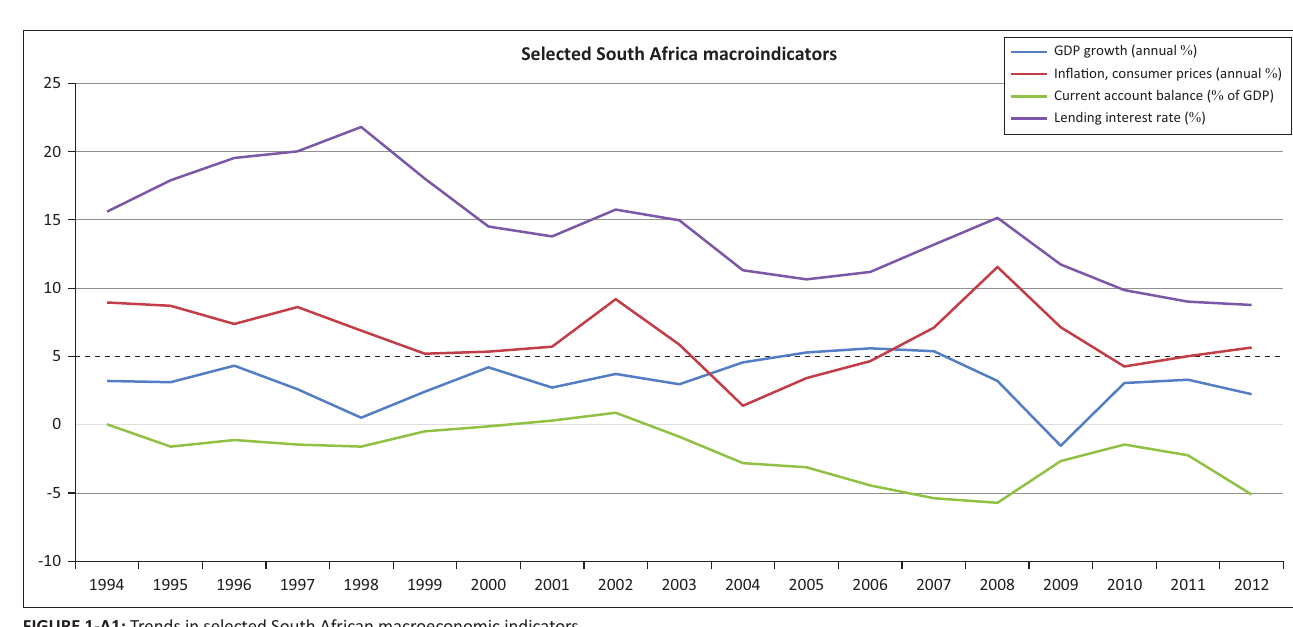
FIGURE 1-A1: Trends in selected South African macroeconomic